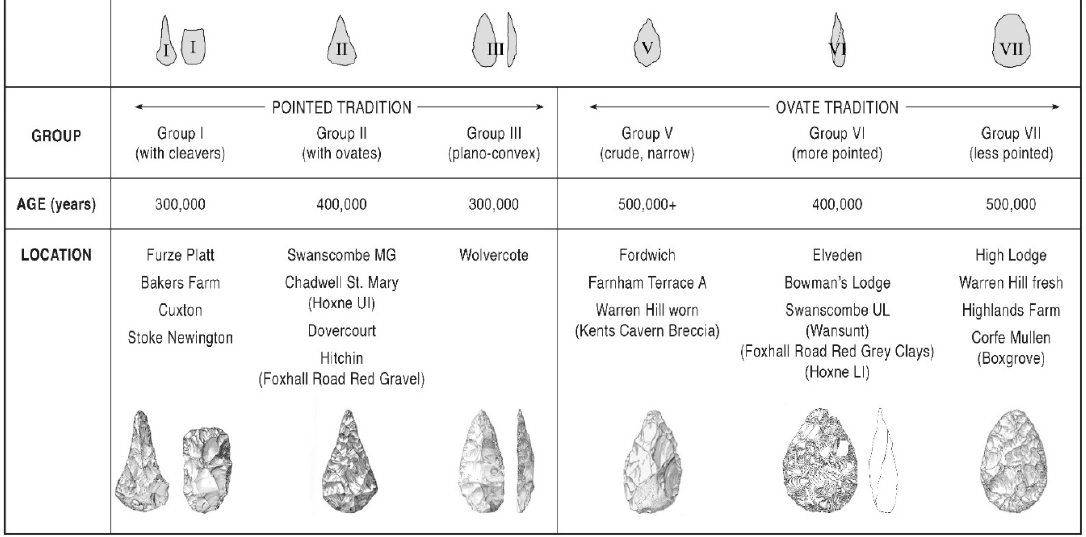
Figure 7. Derek Roe’s (1968) hand-axe groups [94], with later additions in parentheses. Roe’s Group IV, to which he allocated material transitional between the ovate and pointed traditions, is excluded, as it contains mixed and seemingly unreliable assemblages (reproduced from [95]).